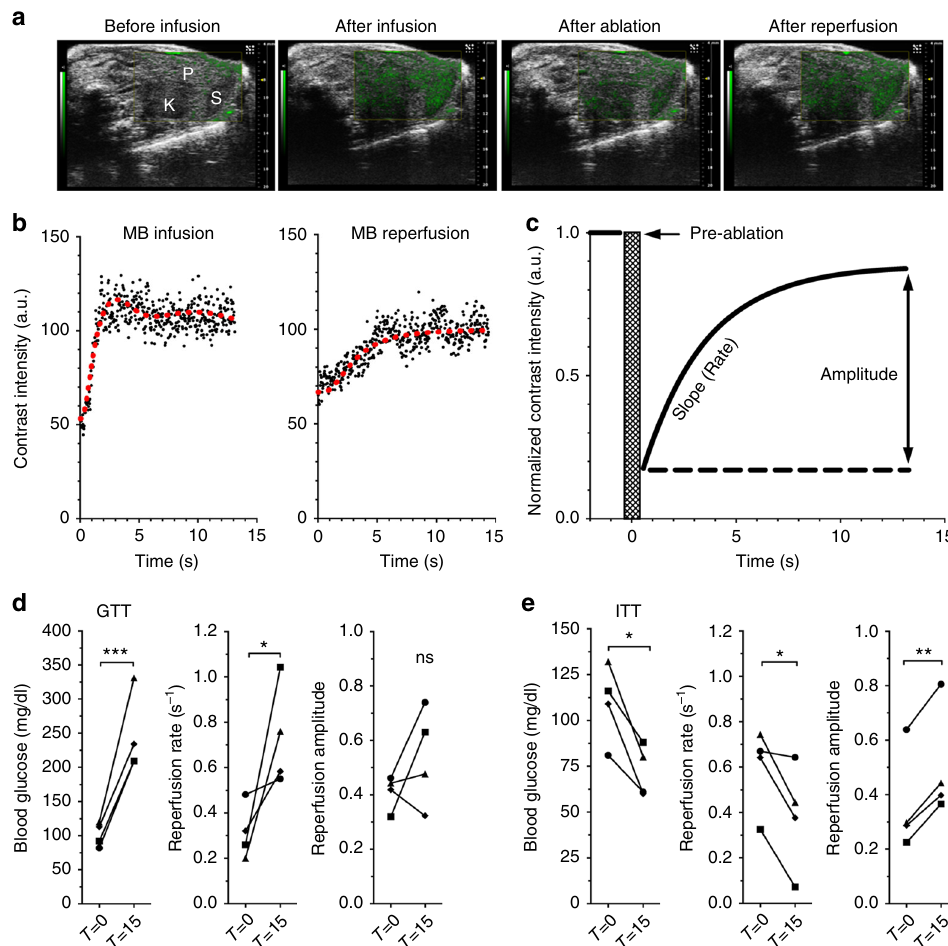
Fig. 1 CEUS measurements and glucose-dependent changes in the pancreatic blood- fl ow dynamics in vivo. a Representative overlay images of NL contrast signal (green) on regular B-mode ultrasound image of pancreas (P), kidney (K), and spleen (S), before and after contrast infusion, and immediately following fl ash destruction (ablation) and reperfusion. b Representative time course of NL contrast signal infusion (left) and reperfusion following fl ash destruction (right). Red line indicates moving average of the signal. c Exponential rise fi t of reperfusion data normalized to pre- fl ash destruction (pre- ablation) intensity. d Changes in blood glucose, pancreas reperfusion rate, and pancreas reperfusion amplitude before ( T = 0) and 15 min after ( T = 15) glucose delivery. e As in d before and 15 min after insulin delivery in C57BL/6 mice. * p < 0.05, ** p < 0.01, *** p < 0.001 comparing groups indicated (paired t -test data in d , e ). Data in d , e represents n = 4 mice each, with each mouse indicated by a different